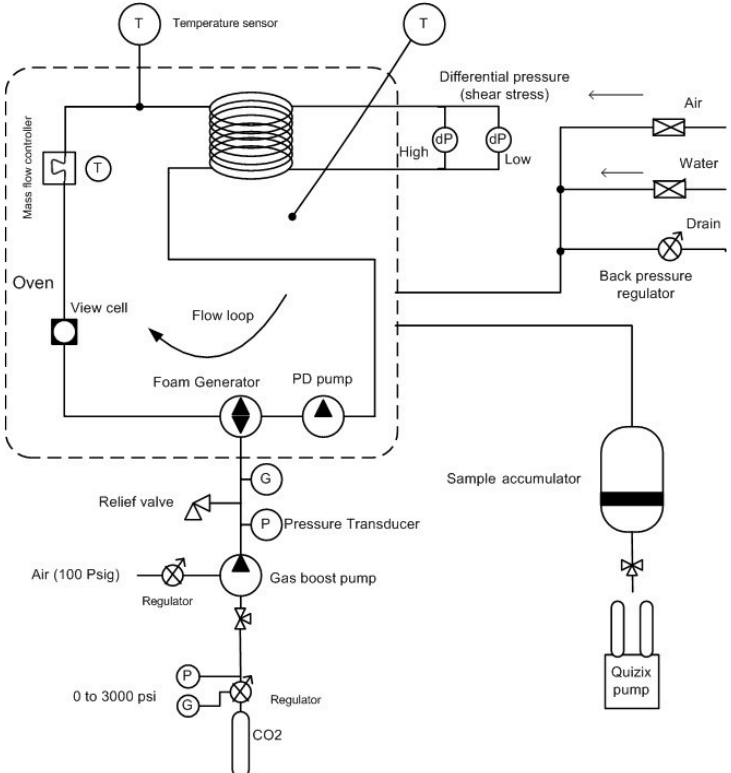
Figure 1. Schematic diagram of a pressurized foam rheometer.